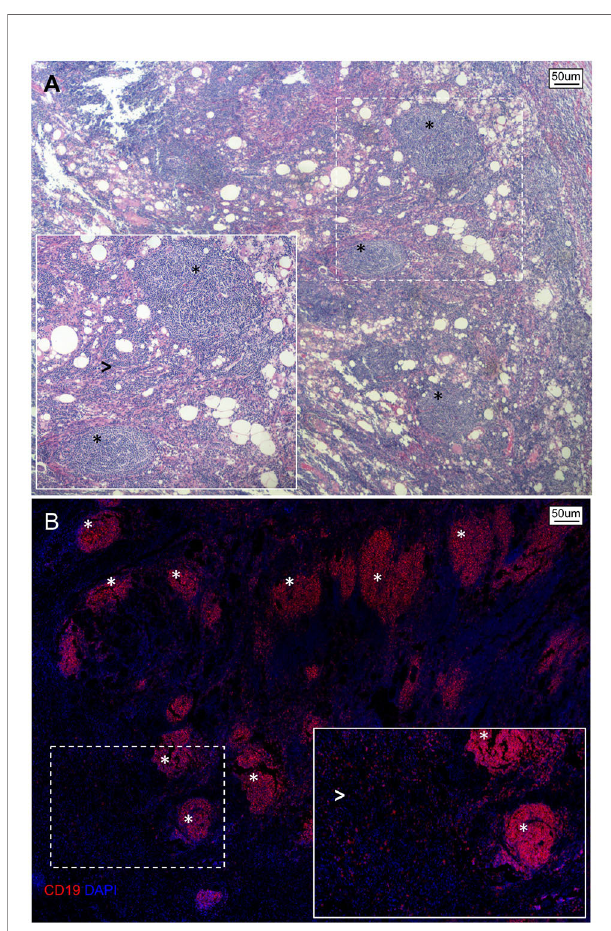
FIGURE 1 | Spatial organization of B lymphocytes in pancreatic adenocarcinoma. (A) Hematoxylin/Eosin stain and (B) immuno fl uorescence staining of a representative tissue section of PDAC showing an abundant in fi ltrate of B lymphocytes organized as either multiple lymphoid structures (asterisks) or spread within the neoplastic lesion and tumor stroma